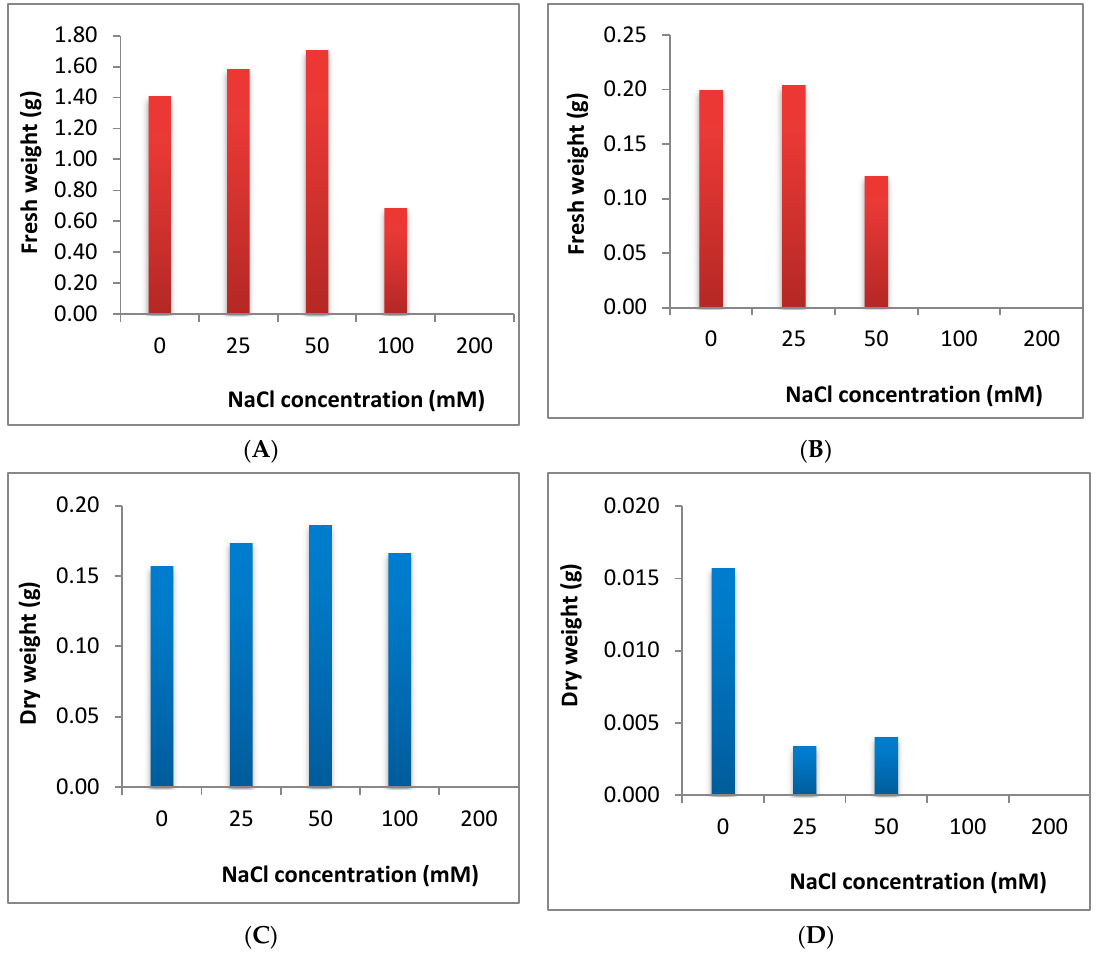
Figure 4. Effect of salinity stress on fresh weight in cucumber ( A ) and in tomato ( B ) and on dry weights of cucumber ( C ) and tomato ( D ).